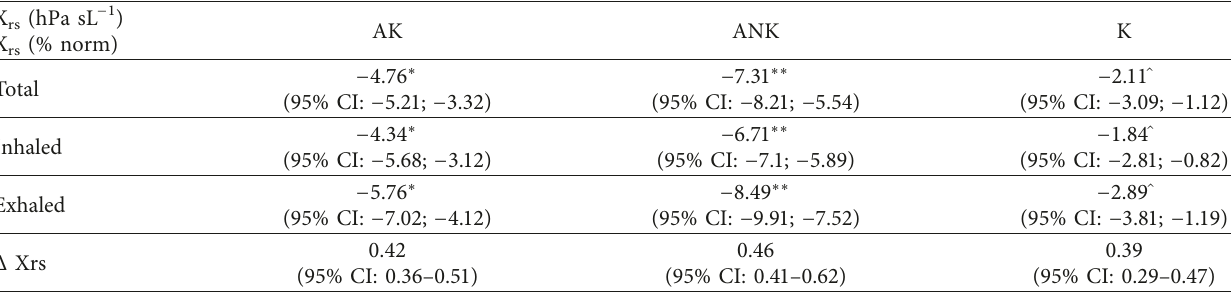
Table 3: Comparison of Xrs values in the studied